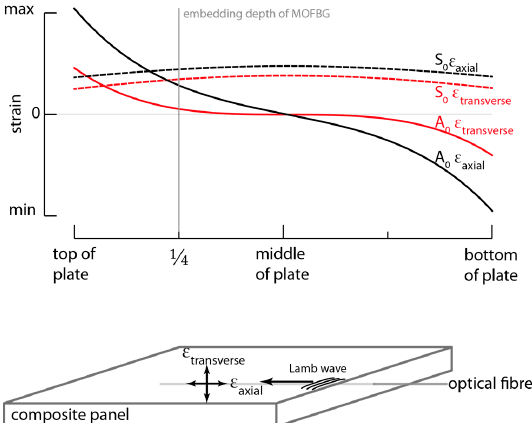
Figure 2. Illustration of strain mode shapes of both S 0 and A 0 waves in the lateral direction of a plate- like structure. The strain induced by an A 0 wave close to the mid-thickness tends to be zero, in contrast to the induced strain of the S 0 wave, which increases at the same depth. An MOFBG embedded at a depth of, for example, ¼ of the panel thickness, that is sensitive to both axial and transverse strain, can exploit this difference to distinguish between the S 0 and A 0 modes [18,21].